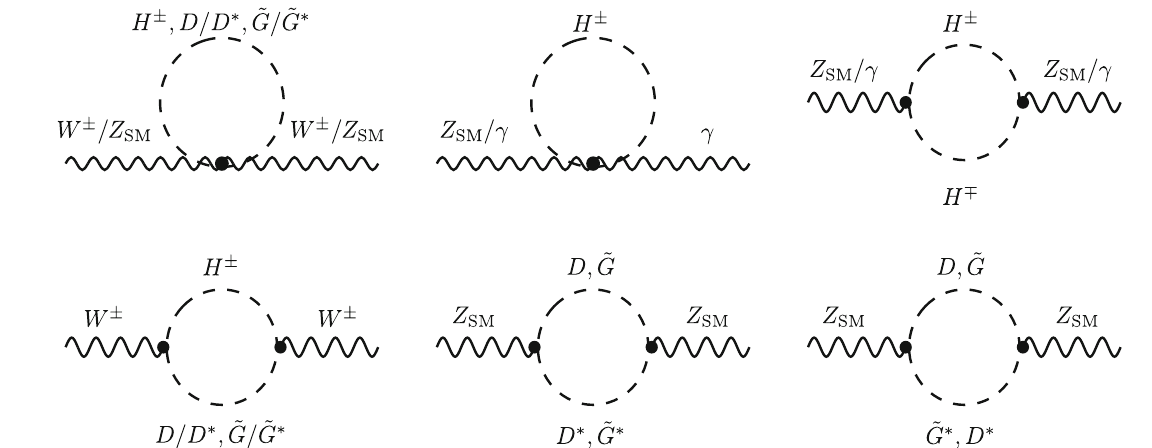
Fig. 5 Vacuum polarization diagrams that contribute to the oblique parameters from the inert doublet H 2 in G2HDM